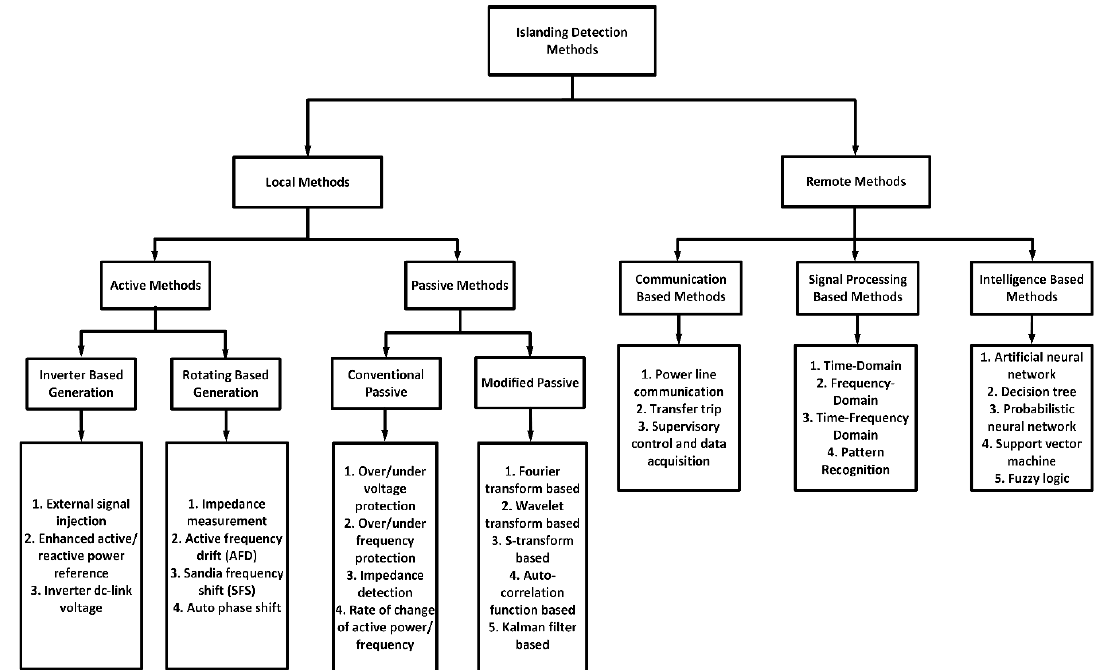
Figure 1. Classification of Various IdMs.